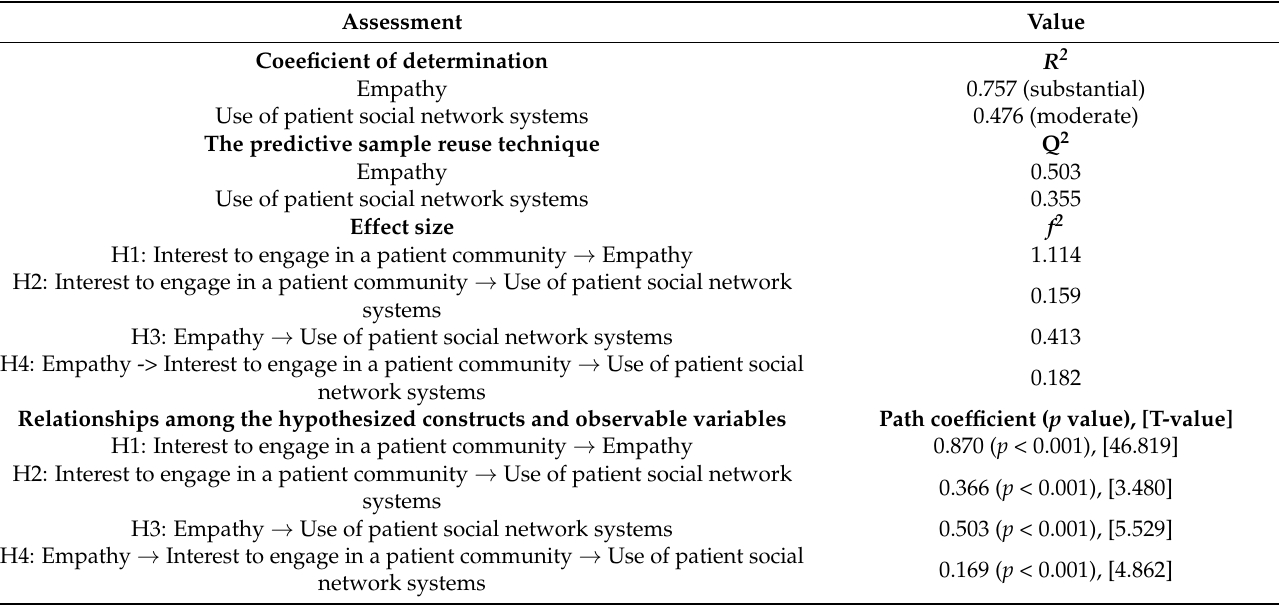
Table 4. Structural model